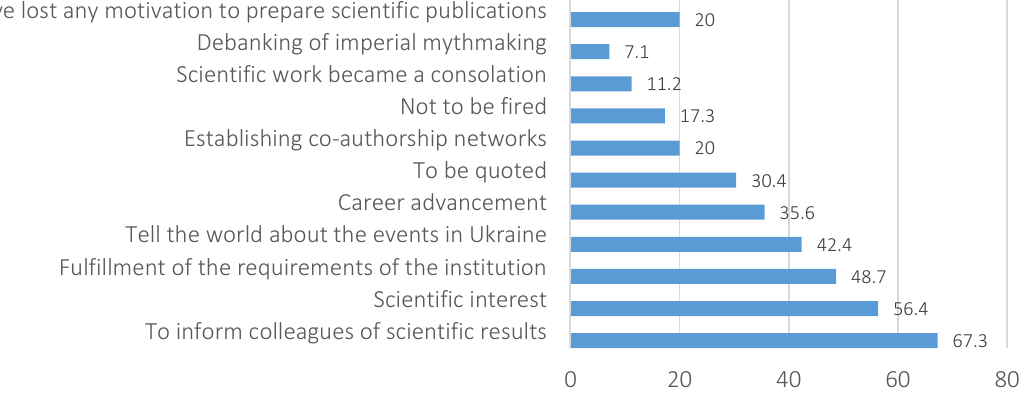
Figure 2. Motivation for publishing scientific articles in war conditions